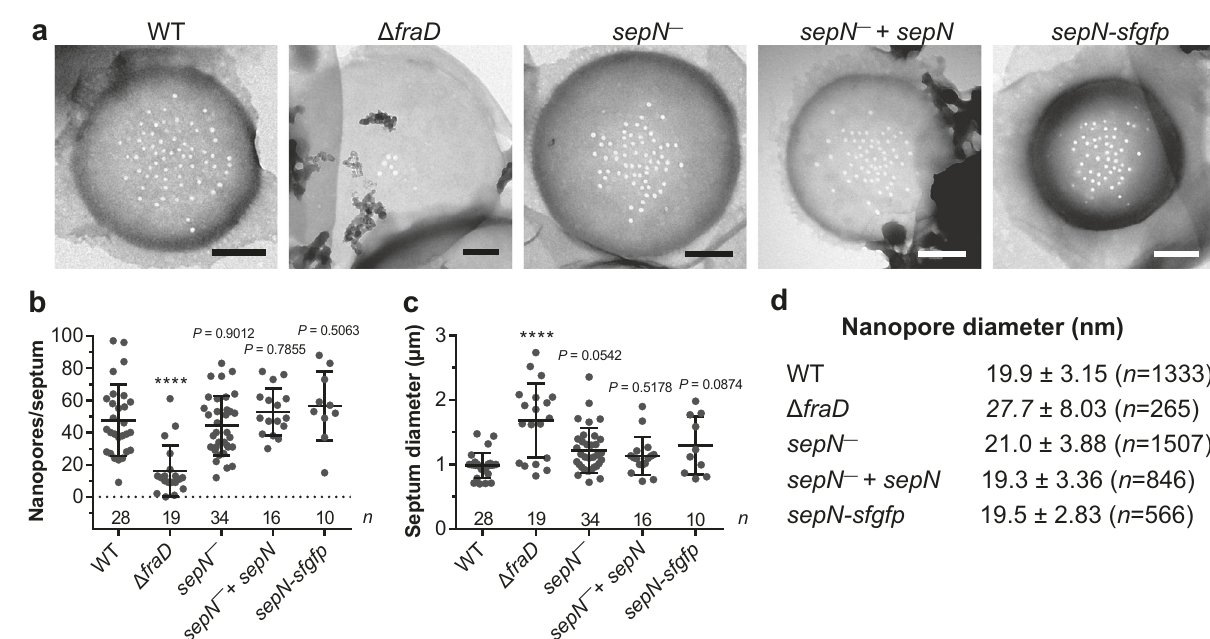
Fig.4|Thenanoporearraysofthe sepN − mutantandWTaresimilar.a SeptalPG discs were isolated and analyzed via transmission electron microscopy. Shown are representative micrographs of the indicated strains. While the Δ fraD mutant showed an aberrant nanopore array, the nanopore arrays of sepN mutants were similar to WT. Bars, 250nm. Experiment was performed four times for sepN − and twice for WT and Δ fraD with similar results. The experiment was performed once for sepN − + sepN and sepN-sfgfp . b , c The diameter of nanopores ( b ) and of the septum ( c ) of mutants analyzed in a . The bars indicate mean and standard devia- tion.Thenumbersbelowindicatethenumberofanalyzedsepta( n ).Onlythe Δ fraD mutantrevealedasigni fi cantlyreducednumberofnanoporesperseptum.Eachdot represents an analyzed PG septum. Statistical signi fi cance was tested via one-way ANOVA followed by Dunnett ’ s muliple comparison test compared to WT without